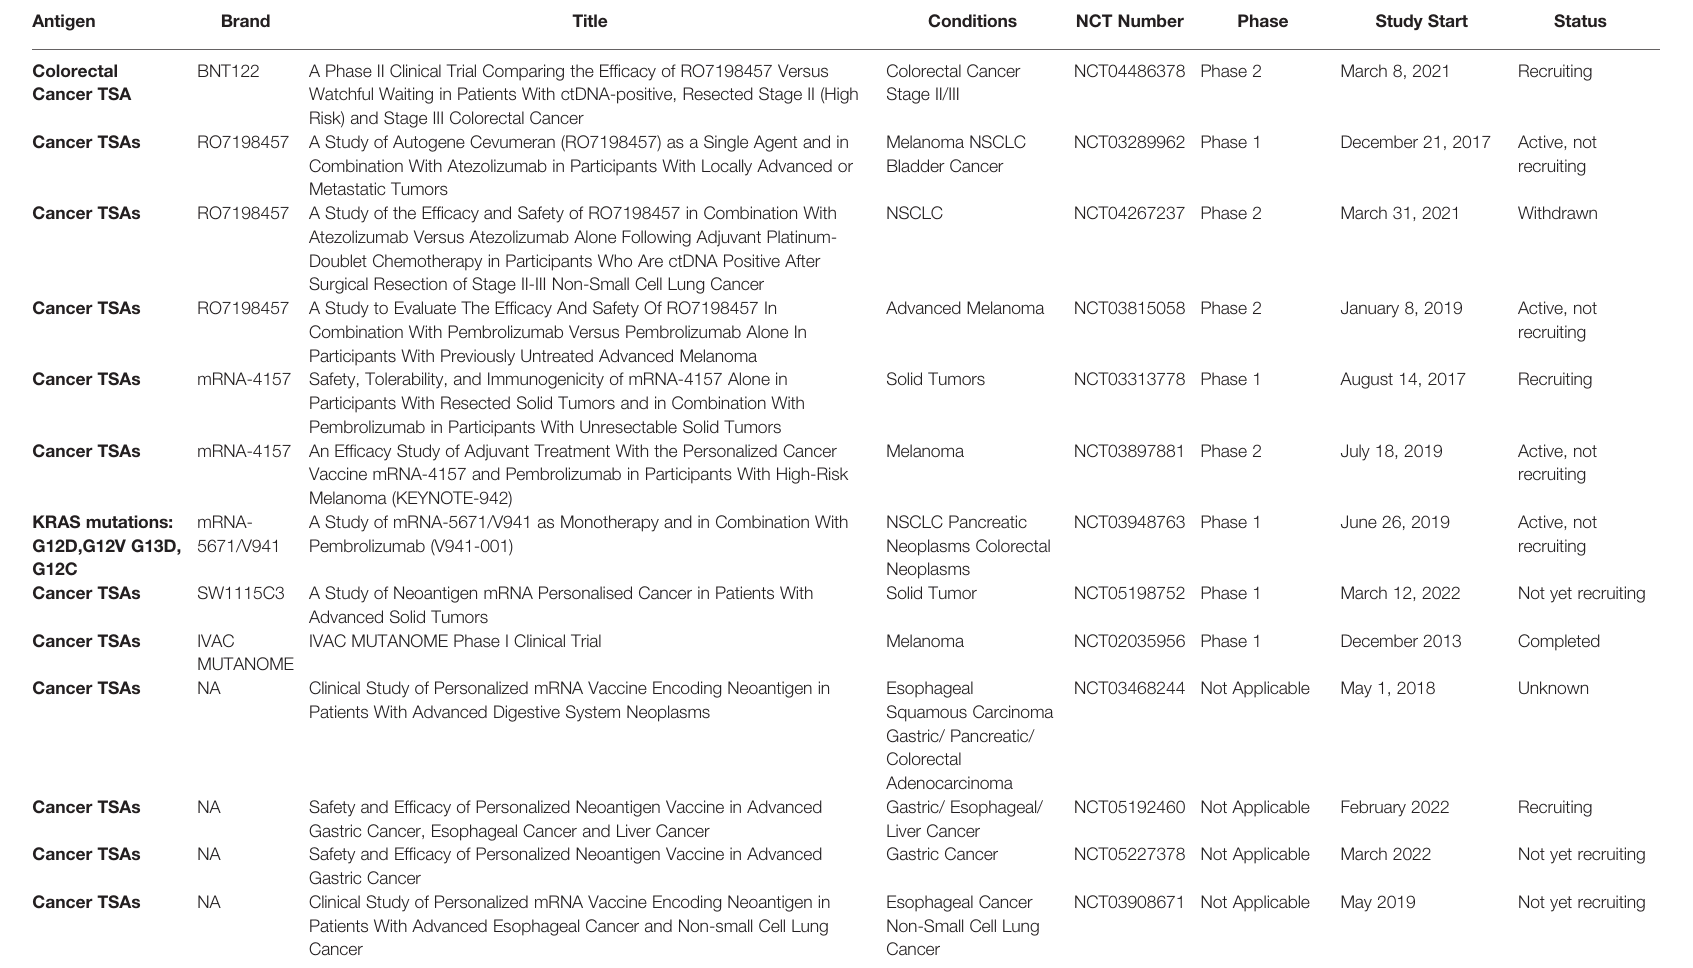
TABLE 2 | Clinical trials of mRNA encoding